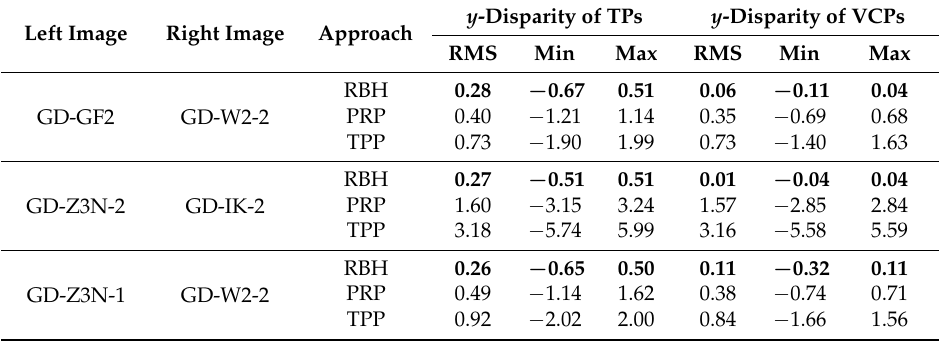
Table 5. The results of the image pairs in the cross-multi-directional-track stereo condition. y -Disparity of Left Image Right Image Approach